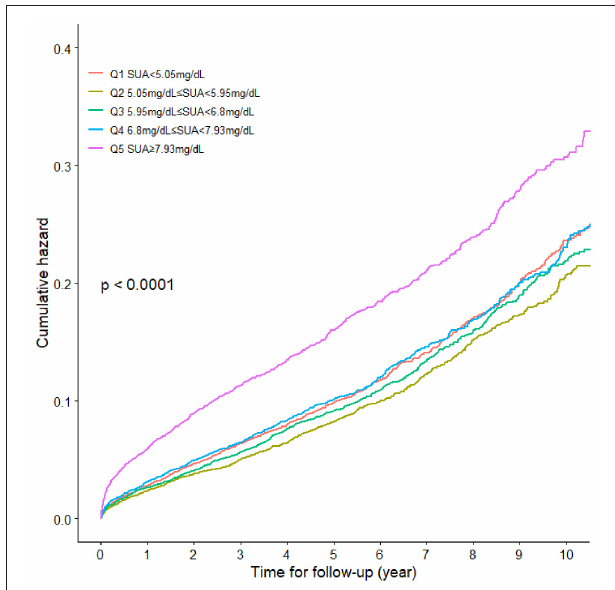
FIGURE 2 | Kaplan-Meier curves for cumulative hazard of long-term all-cause mortality.